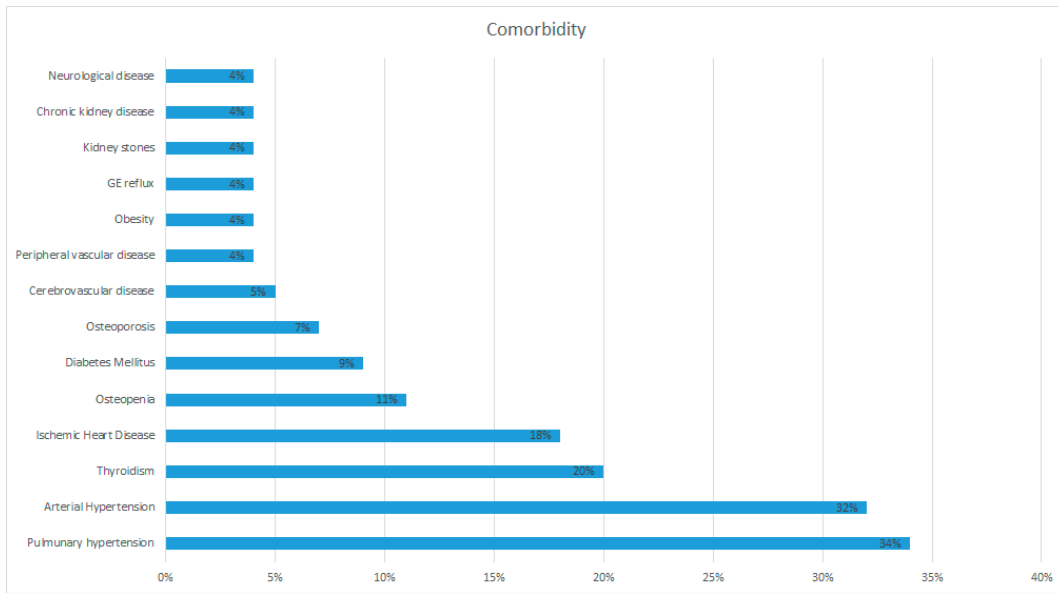
Figure 14. Prevalence of comorbidities in the studied population.